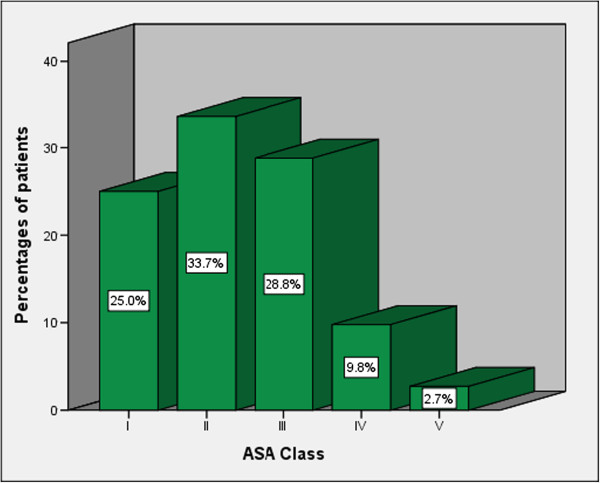
Distribution of patients according to ASA classification.